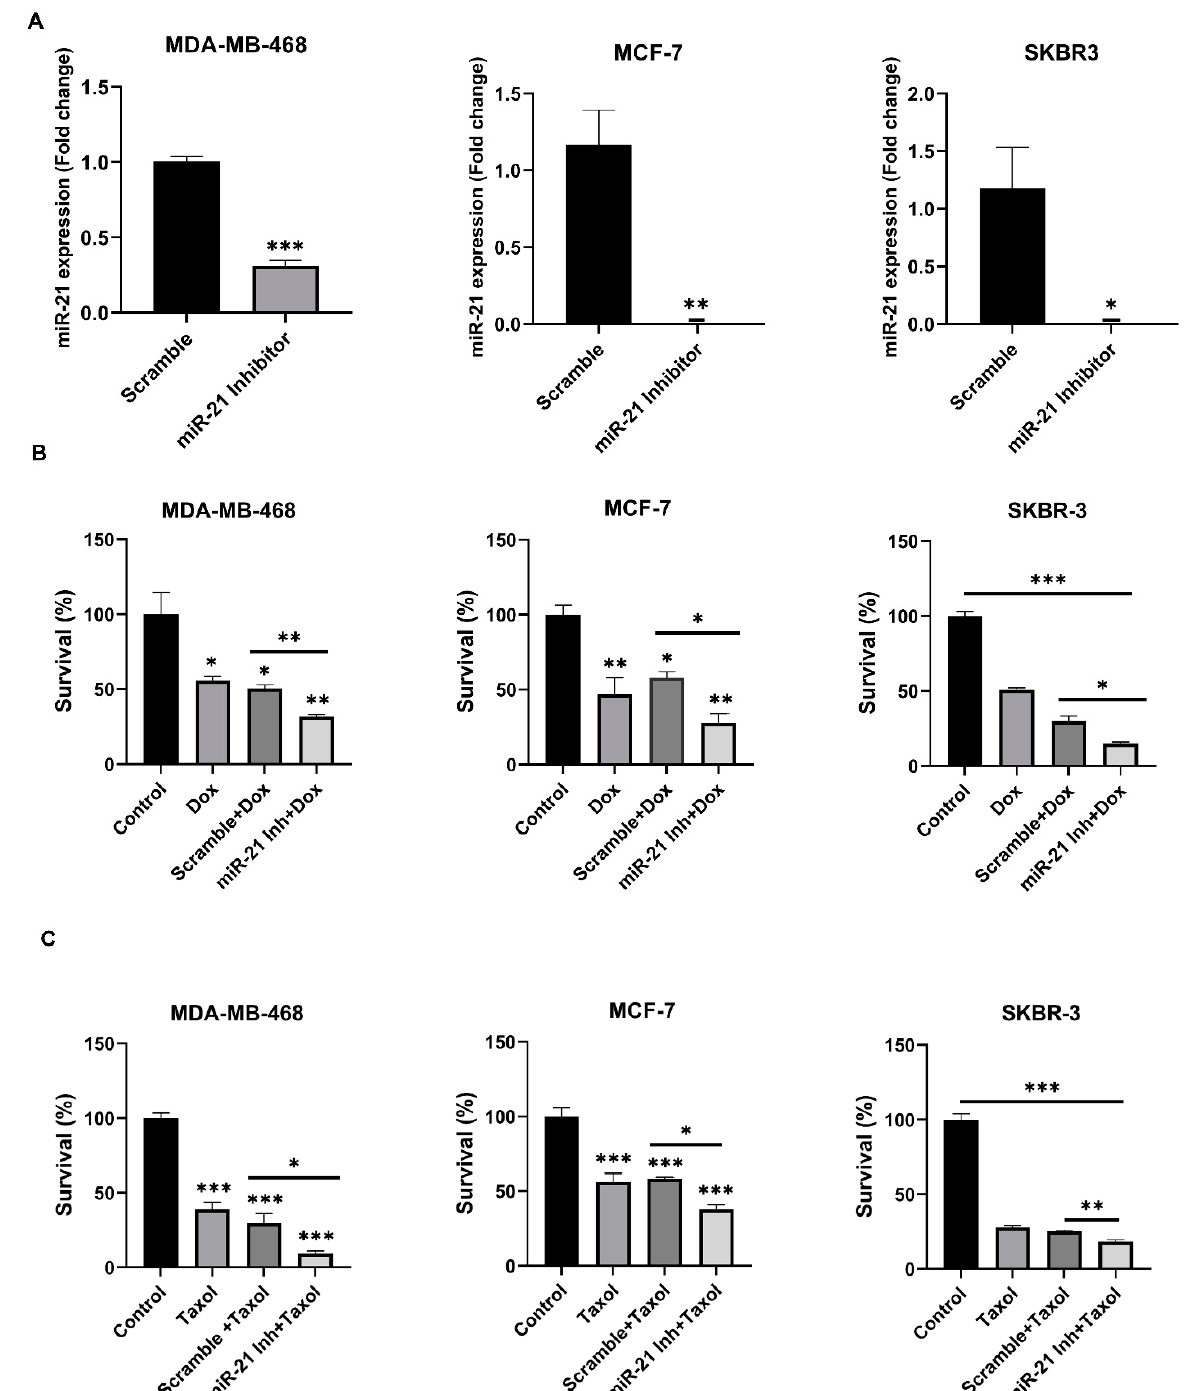
Figure 5. Chemosensitizing effect of miR-21 − / − in breast cancer cells. Knockdown of miR-21 by transfecting MDA-MB-468, MCF-7 and SKBR-3 cells with miR-21 inhibitor sensitizes them to chemotherapy drugs; ( A ) 90 nM miR-21 inhibitor causes a ~70% decrease in miR-21 expression in MDA-MB-468 cells compared to scramble, while 90 nM in MCF-7, and 30 nM in SKBR-3 cells, caused almost complete miR-21 inhibition compared to scramble. ( B ) At 48 h post-treatment, miR-21 inhibition combined with doxorubicin caused a ~40%, ~50%, and ~50% decrease in cell survival of MDA-MB-468, MCF-7, and SKBR-3, respectively, compared to scramble control. ( C ) At 48 h post-treatment, miR-21 inhibition combined with taxol caused a ~70%, ~53% and ~28% decrease in the cell survival of MDA-MB-468, MCF-7, and SKBR-3, respectively compared to scramble control. All the in vitro experiments were done in triplicates or quadruplets ( n = 3/group), *** p < 0.001 or ** p <0.01 or * p < 0.05, determined by two-way ANOVA with Bonferroni post-test or student’s t -test.